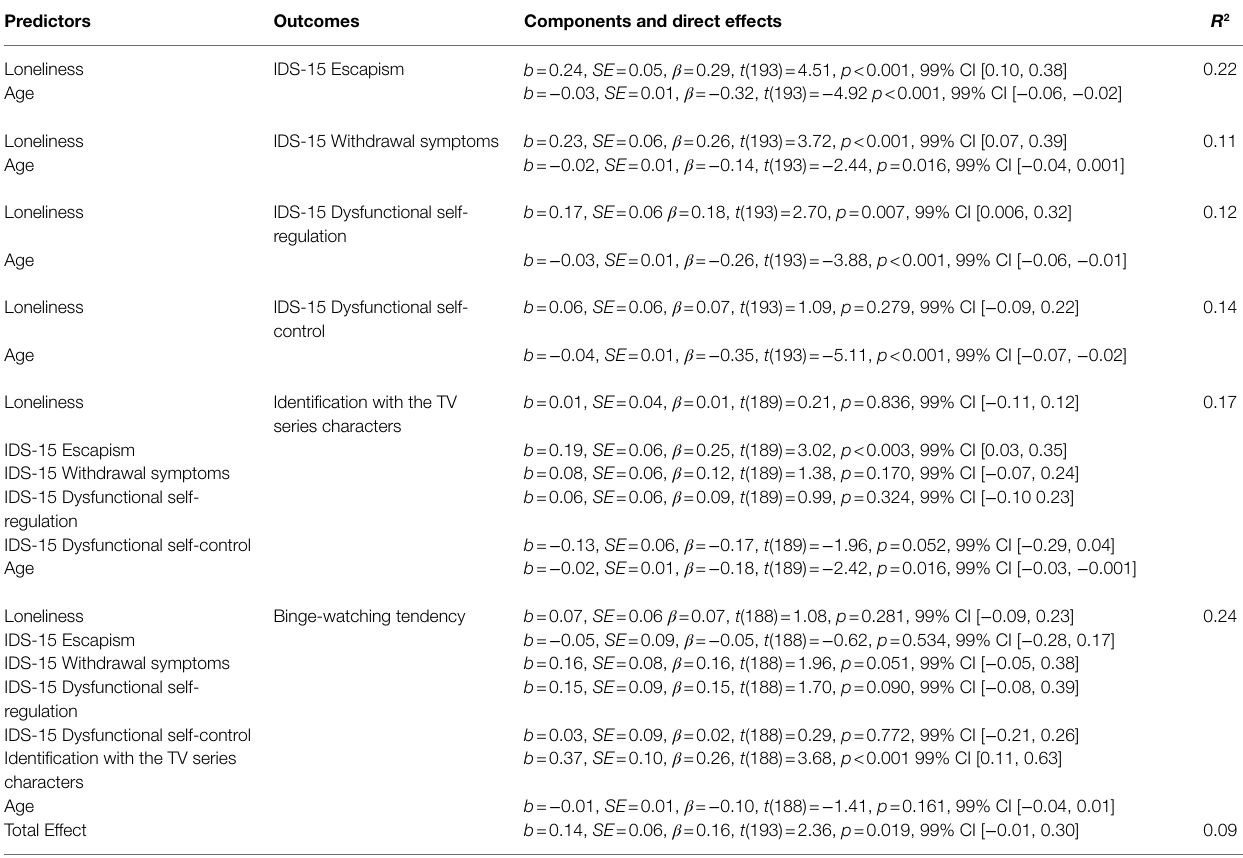
TABLE 2 | Components, direct effects and total effect. Predictors Outcomes Components and direct